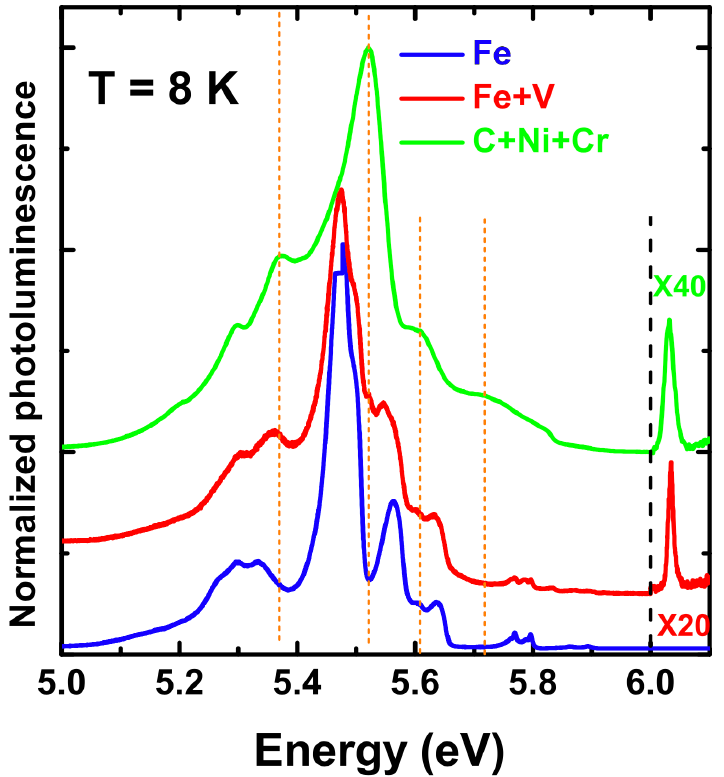
Figure 9. The 8 K macro-photoluminescence spectra in the 5–6.1 eV range of several samples showing the phonon-assisted transitions typical of hexagonal boron nitride (hBN; blue spectrum), mixed with the undulations linked to rBN and bBN inclusions impurities (green and red spectra). The signature of the direct bandgap of bBN is detected by a peak at 6.035 eV, following